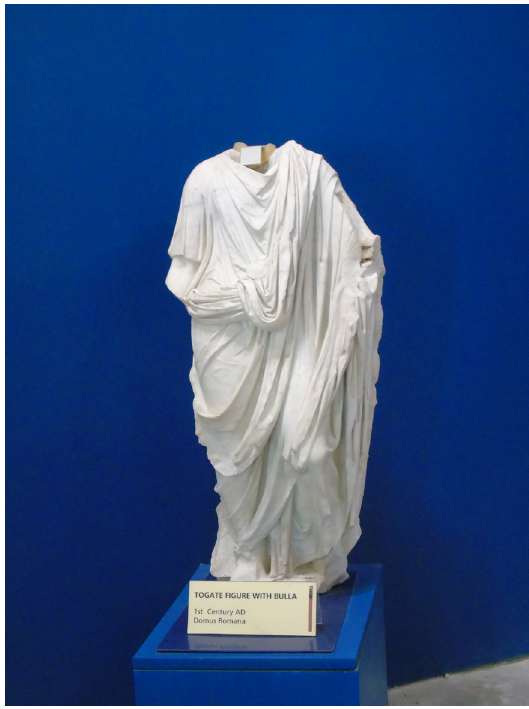
Figure 7: Statue of a young boy wearing a toga – the future emperor Nero – from the Domus Romana (Photo: author, courtesy of Heritage Malta).